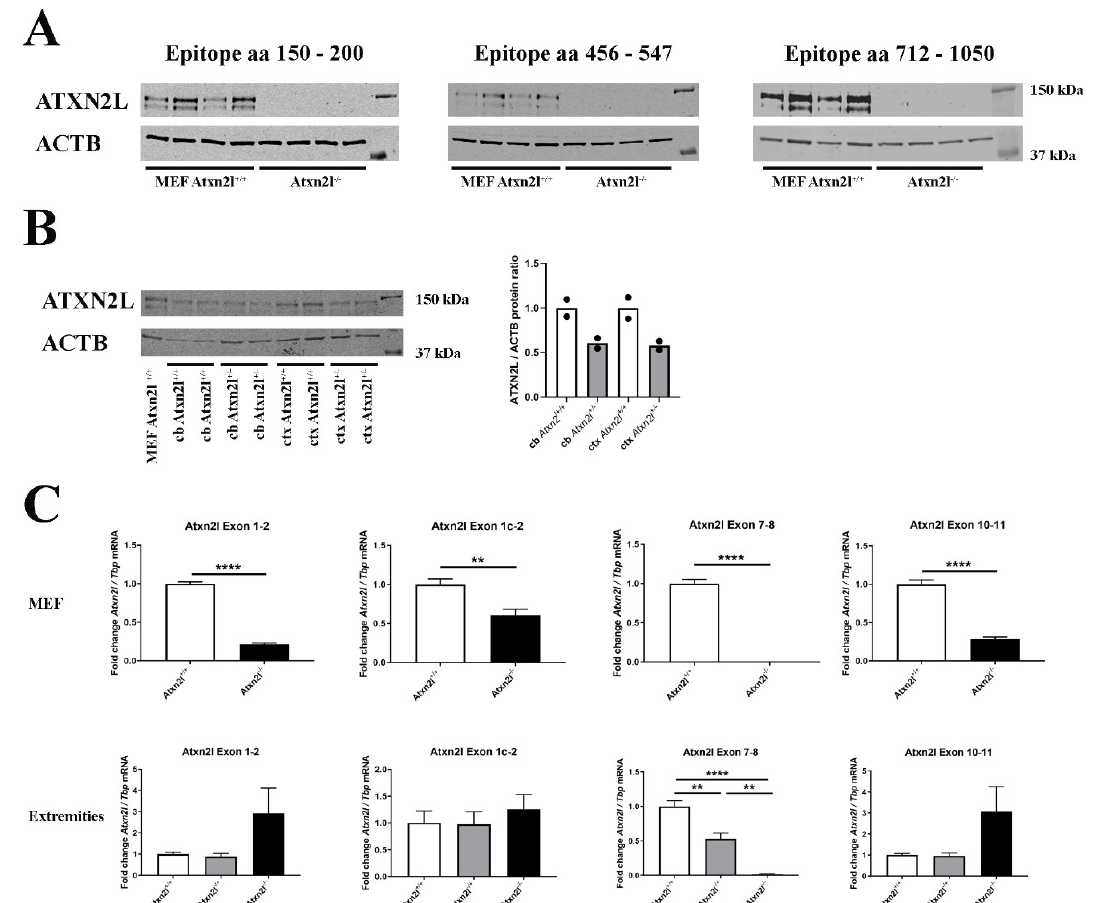
Figure 2. ( A ) Protein abundance of 3 different epitopes spanning ATXN2L in control Atxn2l +/+ and homozygous Atxn2l −/− MEF ( n = 4vs4). The protein was completely absent in three assessed epitopes from residue 150 until the most C-terminal region (aa: amino acid). ( B ) Protein abundance of ATXN2L in heterozygous Atxn2l +/− cerebellum (cb) compared to wildtype littermates, or in heterozygous Atxn2l +/− cortex (ctx), in comparison to one wildtype Atxn2l +/+ MEF line. MEFs exhibit two specific bands of ATXN2L, in contrast to brain tissue where the larger band dominates. The overall ATXN2L levels were decreased to approx. 50% in heterozygous tissues ( n = 2). Detection was done for the epitope aa 712-1050. ( C ) In Atxn2l −/− MEF (upper row, n = 4vs4), RT-qPCR showed that mRNA expression of Atxn2l was absent at the boundary between exons 7-8 that was genetically deleted, and significantly reduced at the boundaries of exons 1-2 and 10-11, possibly due to nonsense-mediated RNA decay. In tissue from fore-/hind-limbs [lower row, 3 wildtype ( Atxn2l +/+ , white bars), 4 heterozygous ( Atxn2l +/− , grey bars), 2 Atxn2l -null embryos ( Atxn2 −/− , black bars)], the Atxn2l mRNA expression measured at the boundary of exons 7-8 was again absent in Atxn2l −/− and reduced by 50% in Atxn2l −/+ mice, whereas 5′-upstream and 3′-downstream from the deletion the increased Atxn2l expression level of null mutants suggested transcript upregulation efforts either via the Atxn2l promoter or via altered mRNA stabilization/degradation to compensate the loss of protein function. The exon 1c-2 assay detects an alternatively spliced isoform. Asterisks represent significance ( p < 0.01 **, p < 0.0001 ****).